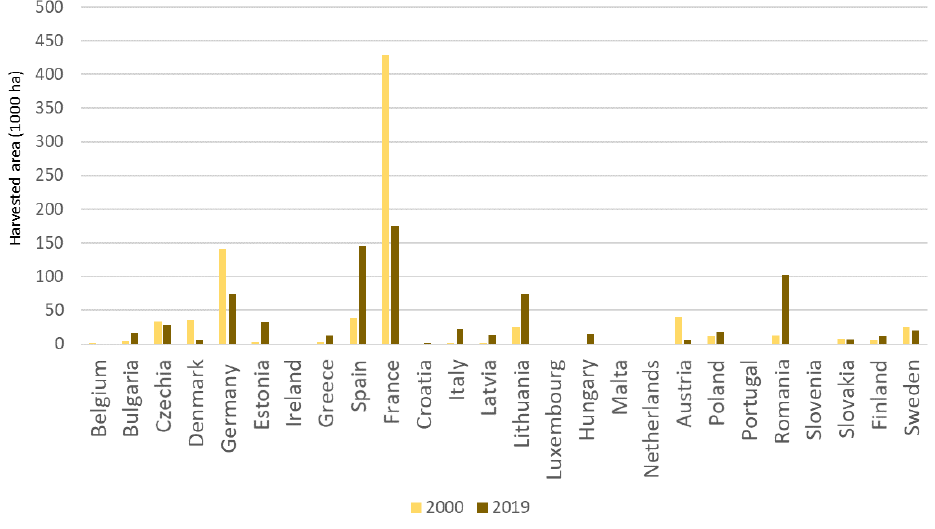
Figure 5. Harvested area of field pea in EU countries in 2000 and 2019 [46].